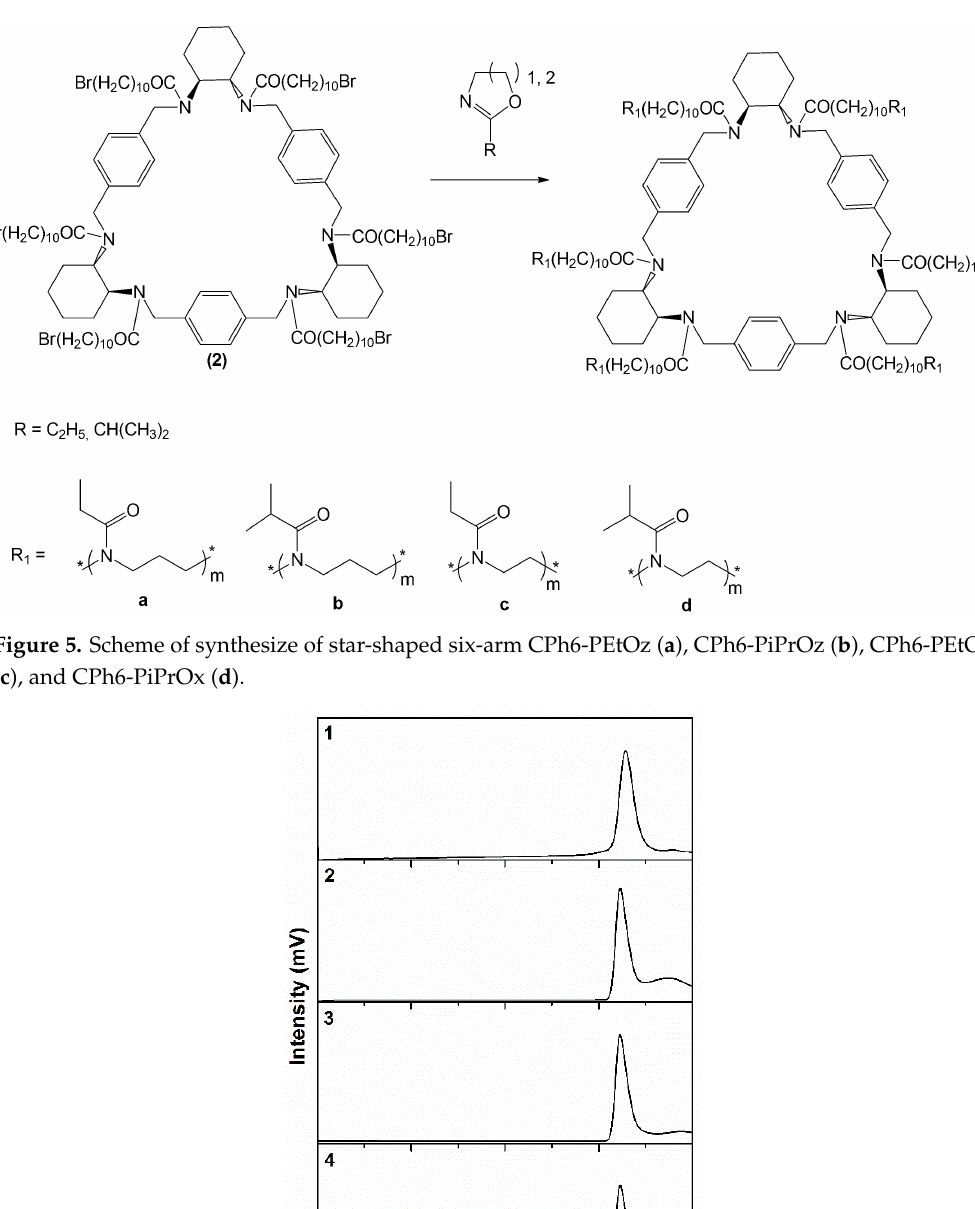
Figure 5. Scheme of synthesize of star-shaped six-arm CPh6-PEtOz ( a ), CPh6-PiPrOz ( b ), CPh6-PEtOx ( c ), and CPh6-PiPrOx ( d ).